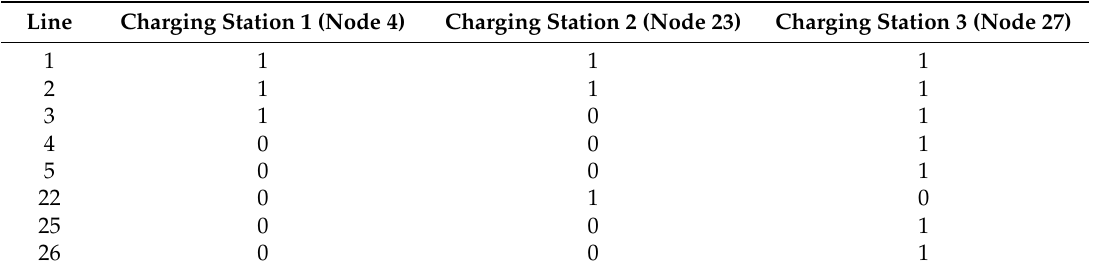
Table 2. Correlation between line power flow and charging power of the charging station.